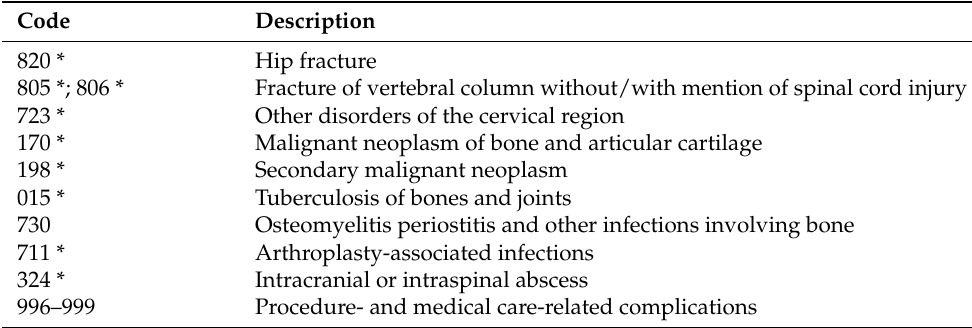
Table A2. Summary of excluded ICD-9 diagnosis codes.